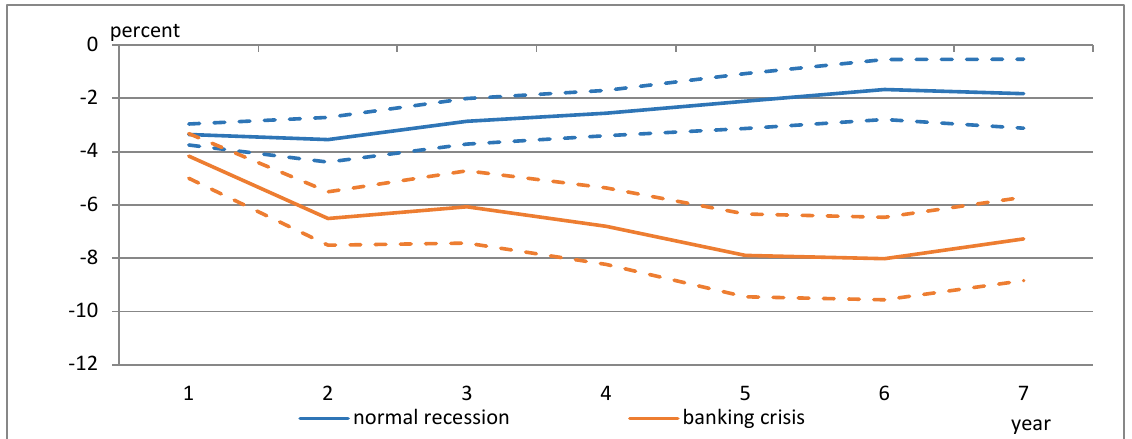
Figure 1: GDP following normal recessions and banking